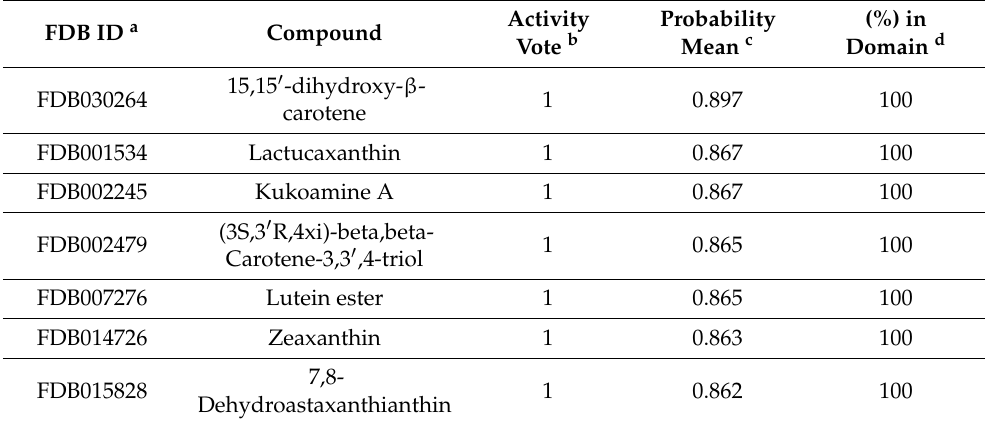
Table 3. List of compounds obtained in the consensus model virtual screening. FDB ID